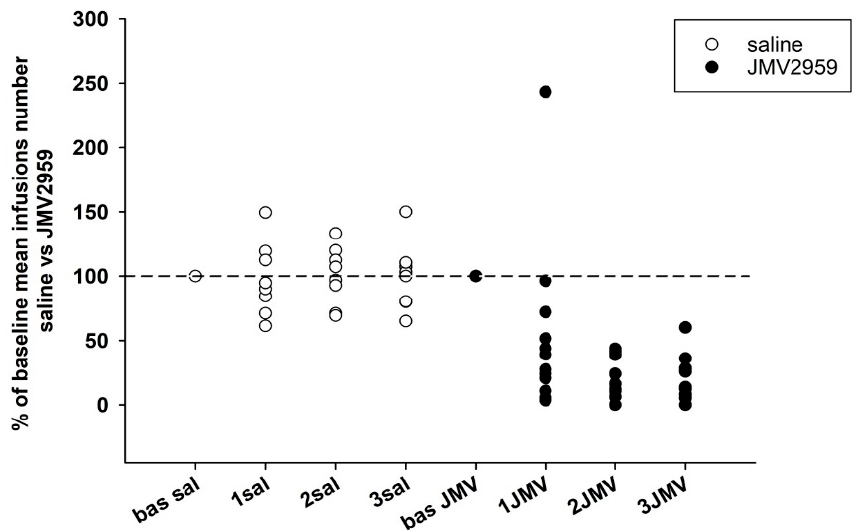
Figure 7. JMV2959 and saline effects on number of infusions during methamphetamine IVSA in single rats in percentage of baseline mean. JMV2959 3 mg/kg and saline were administered i.p. 20 min before the session. The effects are illustrated as follows: saline (open circle); JMV2959 (filled circle). The dotted line shows the baseline mean level (100%).